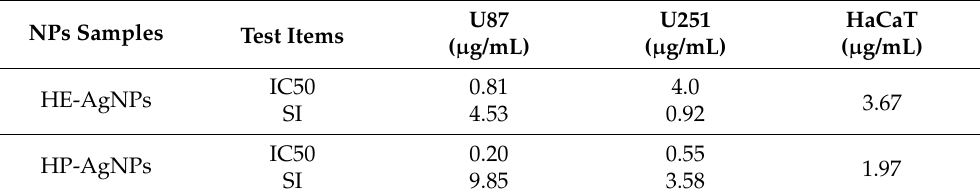
Figure 7. Cytotoxicity of HE-AgNPs ( A ) and HP-AgNPs ( B ) on the U251, U87, and HaCaT cell lines as obtained from MTT assays. Table 3. IC 50 values and selectivity index (SI) of